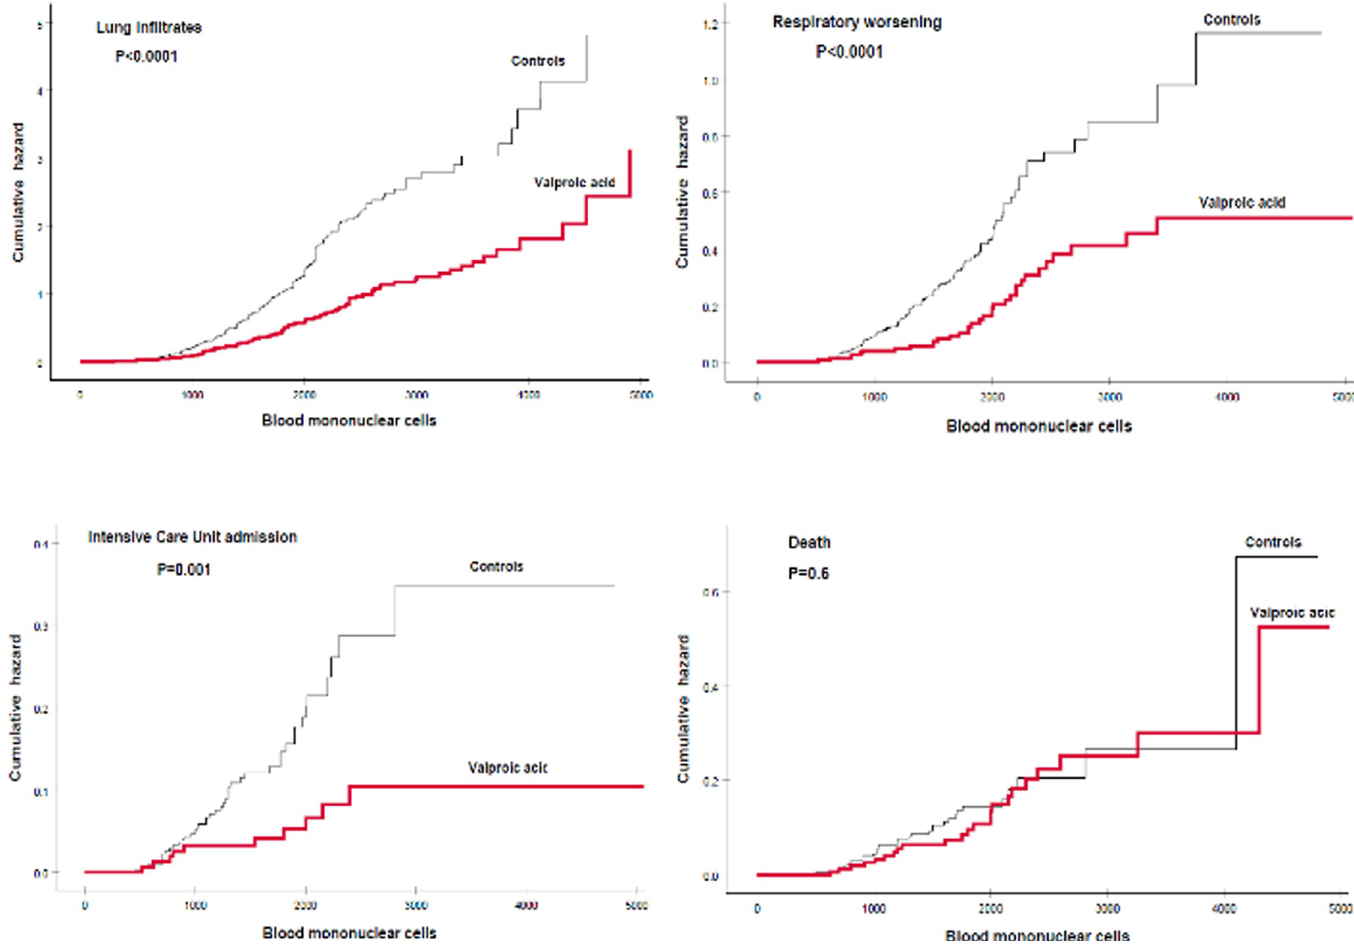
Fig 1. Hazard functions for the development of diverse clinical outcomes according to the blood mononuclear cell count (cells/ μ ).